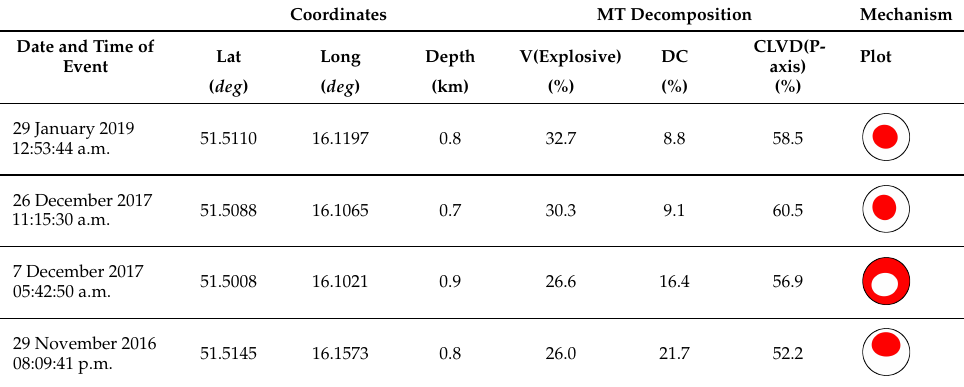
Table 4. Source parameters (moment tensor, source components and focal mechanism) of the selected seismic